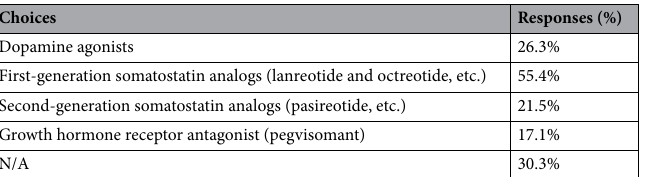
Table 1. Medication used for GH-secreting adenomas initial treatment (according to neurosurgeons).